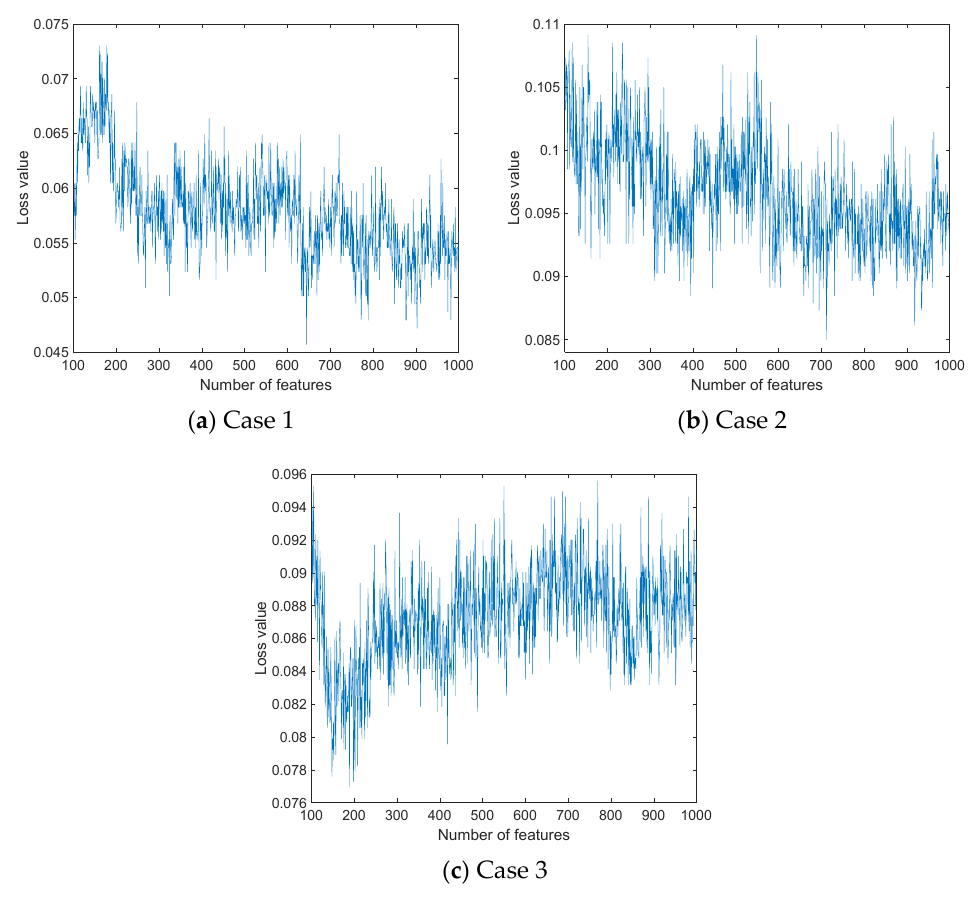
Figure 5. Feature selection processes of the cases.